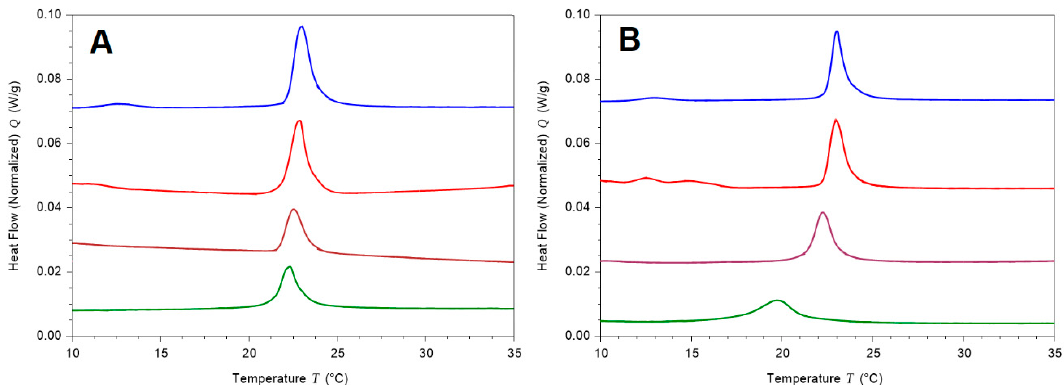
Figure 1. Thermotropic profile of MLVs made up of ( A ) DMPC and ( B ) DMPC-DMPG (3:1), under different amounts of imine. Compound–lipid molar ratios: 0:1 (---); 1:50 (---); 1:25 (---); and 1:10 (---).